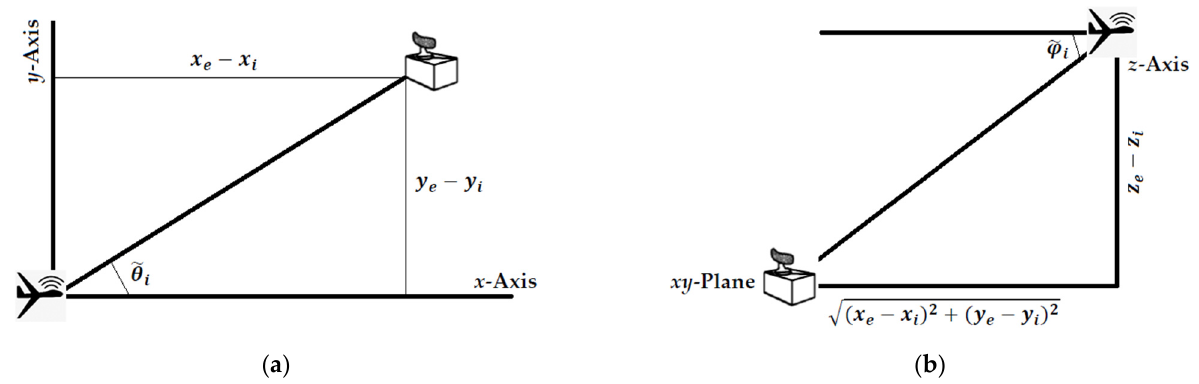
Figure 1. Geometrical illustration of the obtained angle measurements: ( a ) azimuth; and ( b ) elevation.